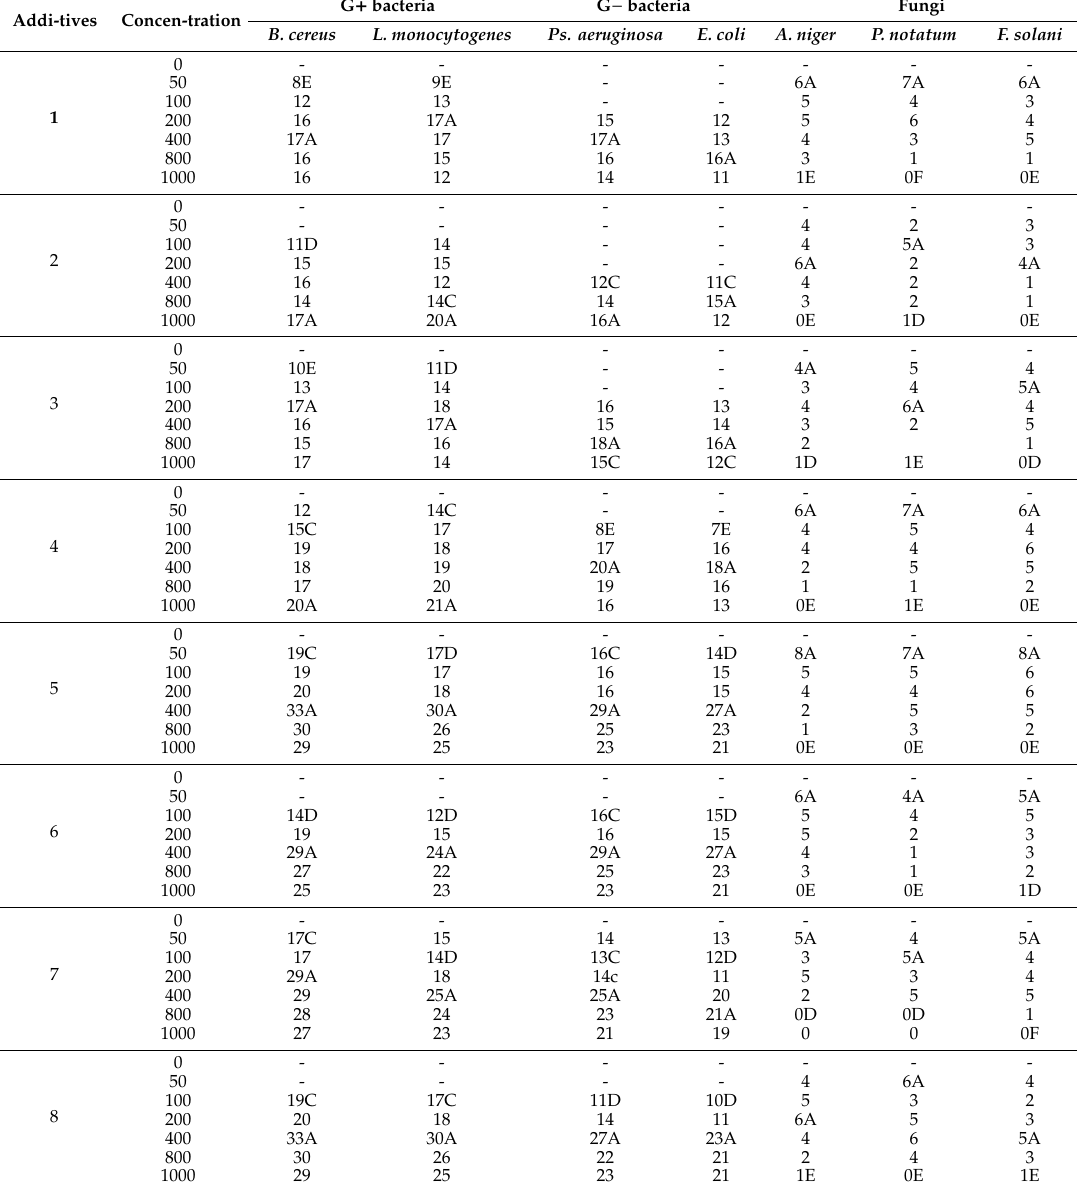
Table 6. Antimicrobial activity of chemical and natural